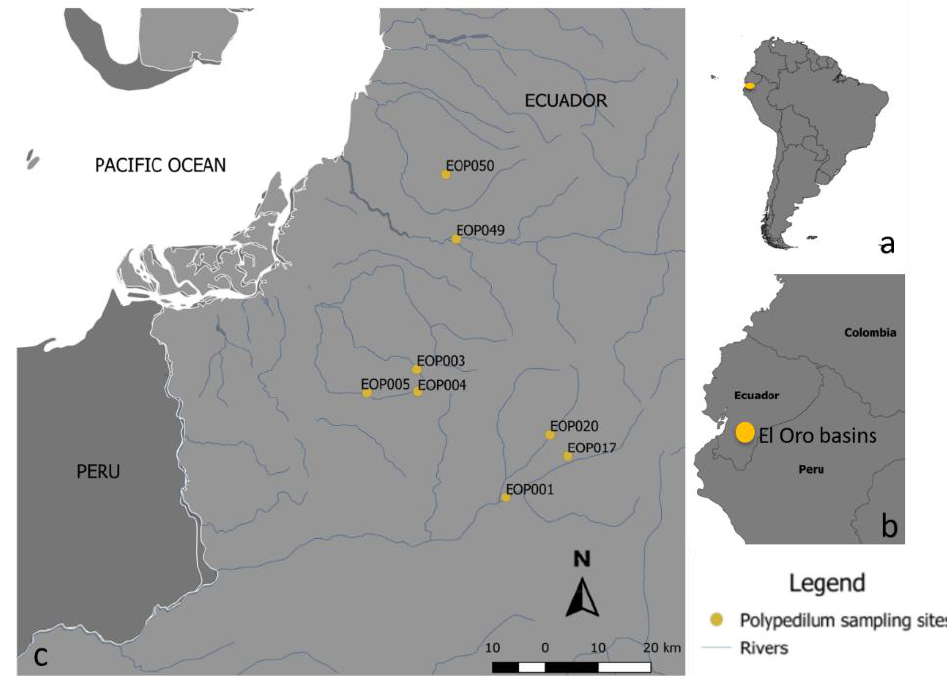
Figure 1. Study sites: ( a ) sites in relation to South America; ( b ) site distribution in Ecuador; and ( c ) study sites in El Oro Province. B1: Arenillas basin (EOP003, EOP004, EOP005); B2: Puyango basin (EOP001, EOP017, EOP020); B3: Jubones basin (EOP049); B4: Siete river basin (EOP050).